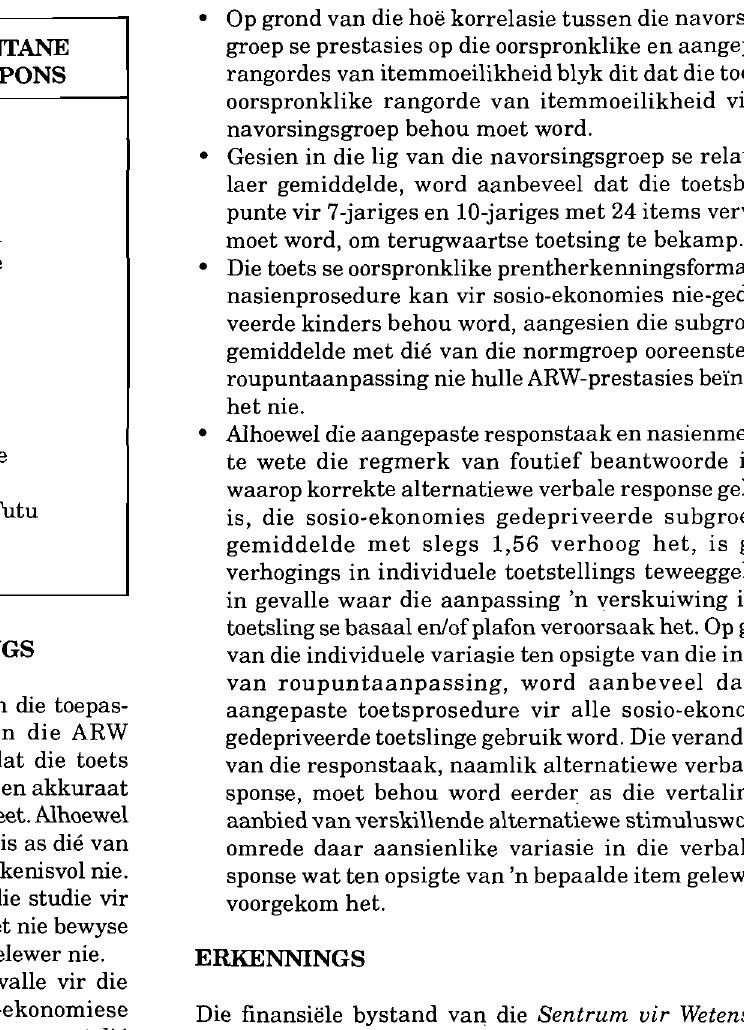
TABEL 13: Spontane alternatiewe verbale res ponse op korrekbeantwoorde toetsitems